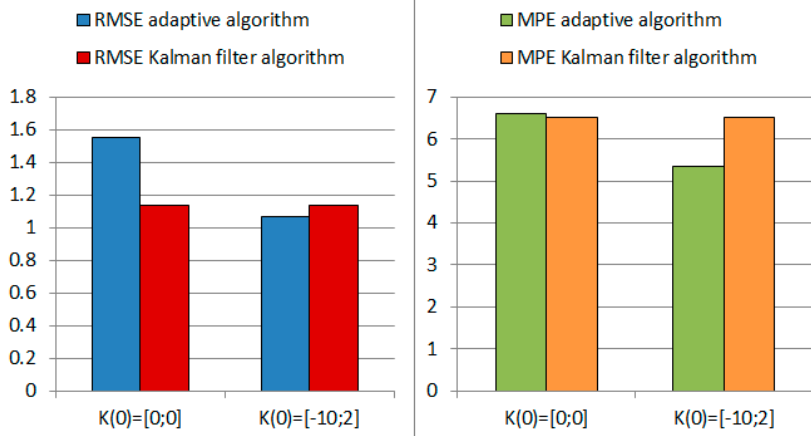
Figure 13. Values of quality indicators for DO signal at different initial gain values.